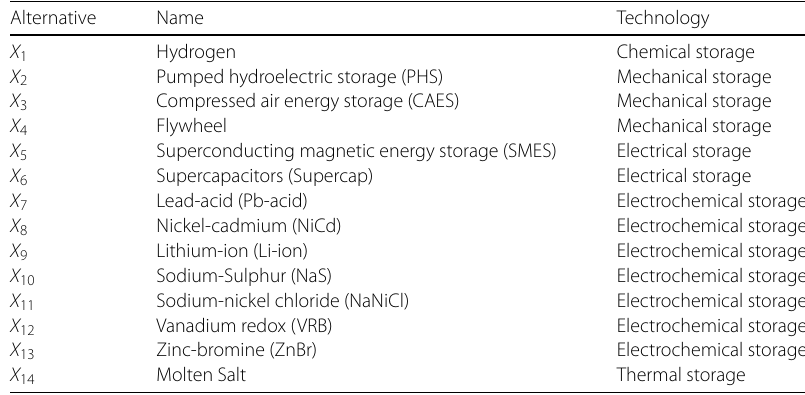
Table 5 The evaluated ESTs